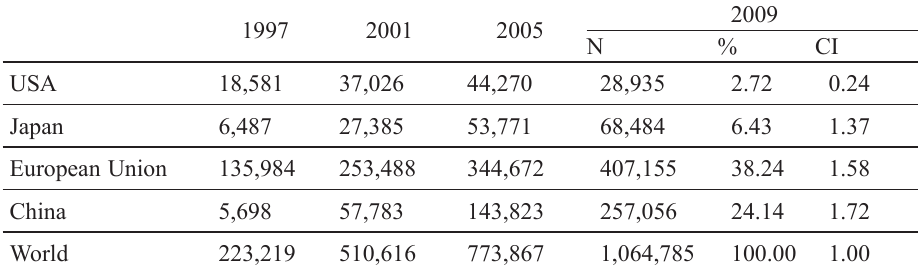
Table 2. International adoption of ISO 9000 in the main global economic